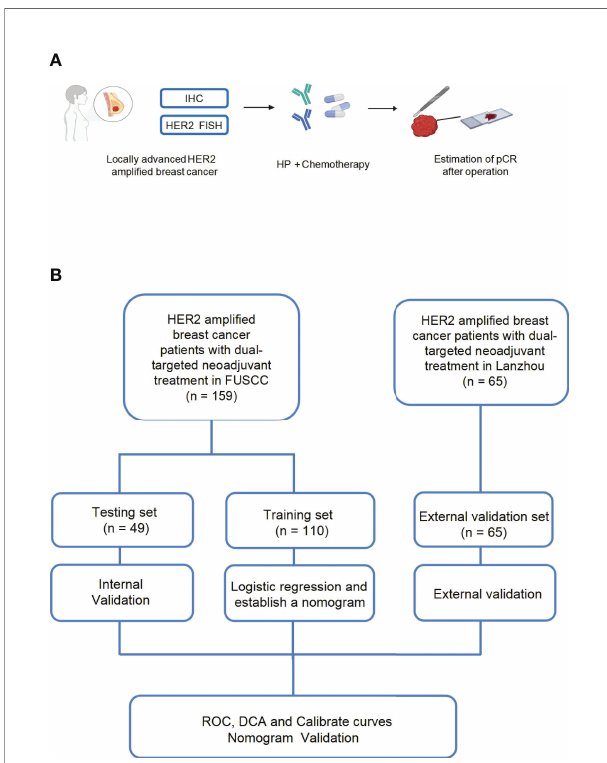
FIGURE 1 | Schematic illustration of our experimental design (A, B) . One hundred fi fty-nine patients with locally advanced HER2-ampli fi ed breast cancer, histologically con fi rmed by core needle biopsy, were selected. HER2- ampli fi ed patients were de fi ned as those who were 2+ or 3+ positive for HER2 overexpression by immunohistochemistry (IHC) or HER2 ampli fi ed by fl uorescence in situ hybridization (FISH) and received neoadjuvant treatment with pertuzumab and trastuzumab plus chemotherapy. Then, pCR was estimated after the surgery.